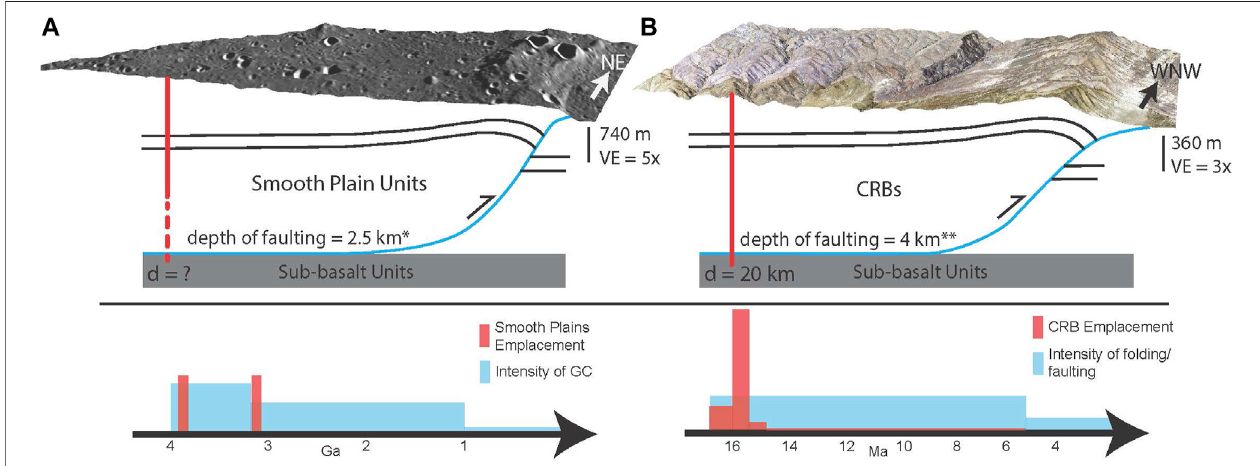
FIGURE 3 | This fi gure compares the geomorphology, subsurface structural interpretation, and timing of formation for thrust fault-related landforms in Mercury ’ s smooth plains units (A) and faults and folds ofthe Yakima Fold Province (B) . Both sets ofstructureshave been modeled withlistric thrusts that root into sub-basalt units and both likely formed topographic expressions during volcanism (Crane and Klimczak, 2019b; Crane, 2020). Imagery and digital elevation models for (A) and (B) are MDIS Global Monochrome Mosaic and DLR DEM for Mercury and NAIP imagery and USGS DEM for Earth. Timing of deformation and volcanism for Mercury (Ostrach et al., 2015; Crane and Klimczak, 2017) and Earth (Reidel, 1984; Reidel et al., 2013a; Kelsey et al., 2017) are shown on billion-year and million-year scales, respectively.